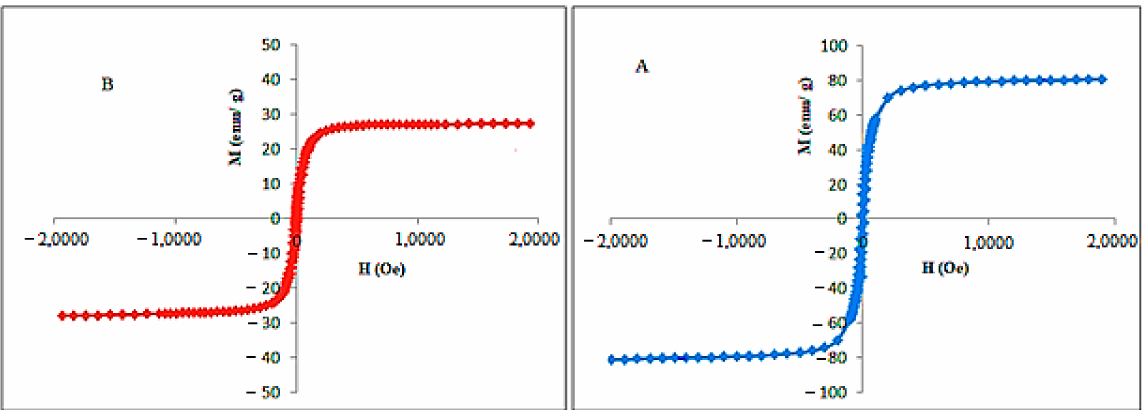
Figure 4. Hysteresis loops for the prepared Fe3O4 nanoparticles ( A ) and FPVAFU-ZLDH ( B ). Notes: The data are presented in terms of Ms, mass magnetization (emu/g), versus H, applied magnetic field (Oe).